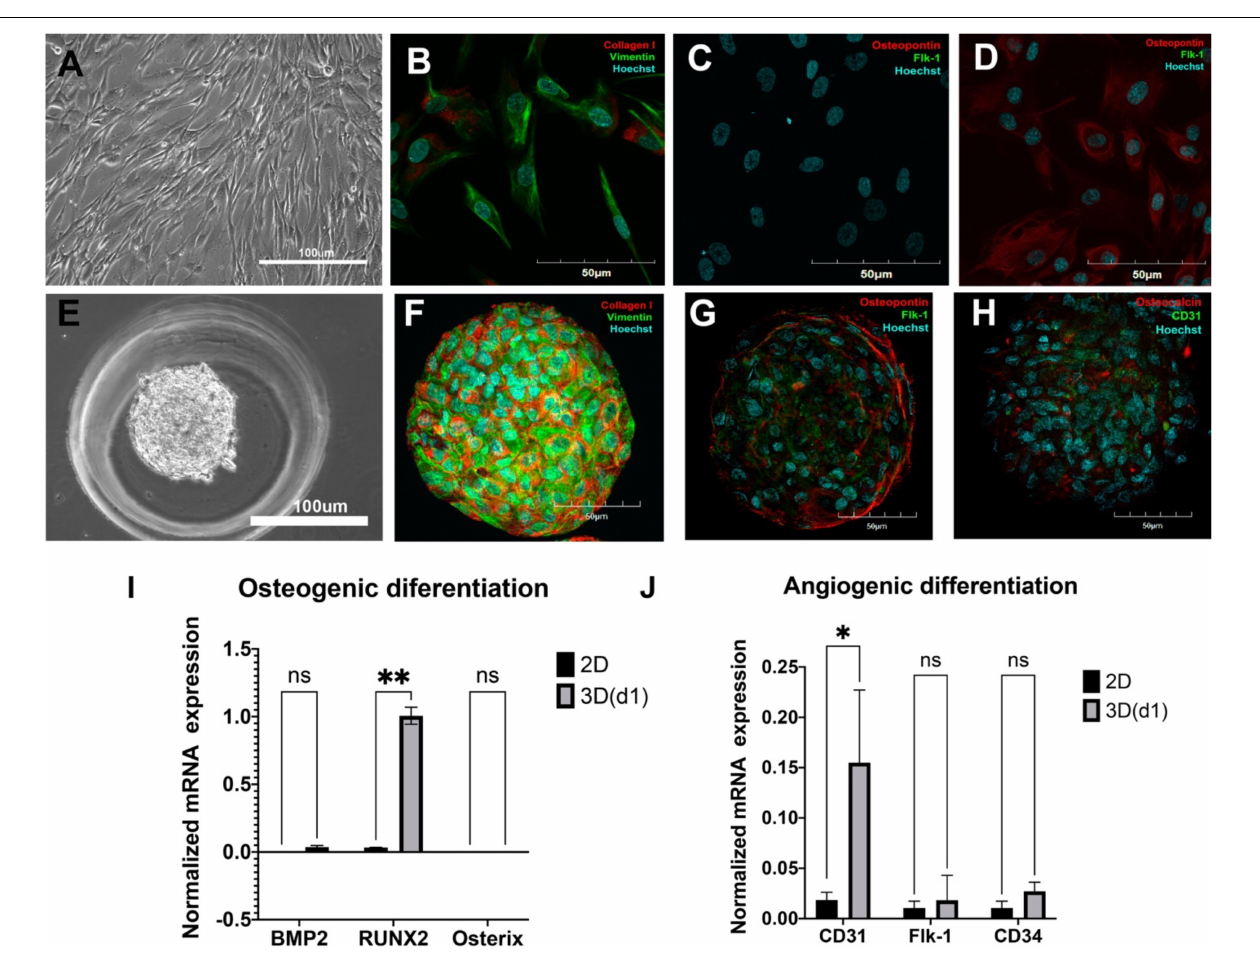
FIGURE 2 | Spontaneous osteogenic and angiogenic differentiation of adipose-derived stromal cells (ADSCs) in 3D but not in 2D culture. (A) Cells were elongated and spindle shaped with a wave pattern of spreading. Light Phase-Contrast Microscopy, scale bar 100 µ m . (B) ADSCs expressed vimentin (green) and collagen type I (red) in 2D culture. (C) Monolayer ADSC culture did not express osteopontin (red)/Flk-1(green). (D) After being cultured in the presence of osteogenic and angiogenic inducers, ADSCs in monolayer cultures started expressing osteopontin (red) but not Flk-1 (green). (B–D) The nuclei were counterstained with Hoechst 33258 (blue). Laser Scanning Confocal Microscopy, scale bars 50 µ m . (E) ADSC aggregated into compact spheroid on day 1. Light Phase-Contrast Microscopy, scale bar 100 µ m . (F) ADSCs expressed vimentin (green) and collagen type I (red) in 3D culture. (G) ADSC spheroid expressed osteopontin (red)/Flk-1(green) on day 7. (H) ADSC spheroid expressed osteocalcin (red) and CD31(green) on day 7. (F–H) The nuclei were counterstained with Hoechst 33258 (blue). Laser Scanning Confocal Microscopy, scale bars 50 µ m . (I) Mean ( ± SEM) osteogenic gene ( BMP2 , Runx2 , Osterix ) expression levels (normalized to housekeeping genes) for 2D and 3D (day 1) cultures. (J) Mean ( ± SEM) angiogenic gene ( CD31 , Flk-1 , CD34 ) expression levels (normalized to housekeeping genes) for 2D and 3D (day 1) cultures. Statistical analysis was performed by paired samples t-test, ∗ p < 0.05, ∗∗ p <